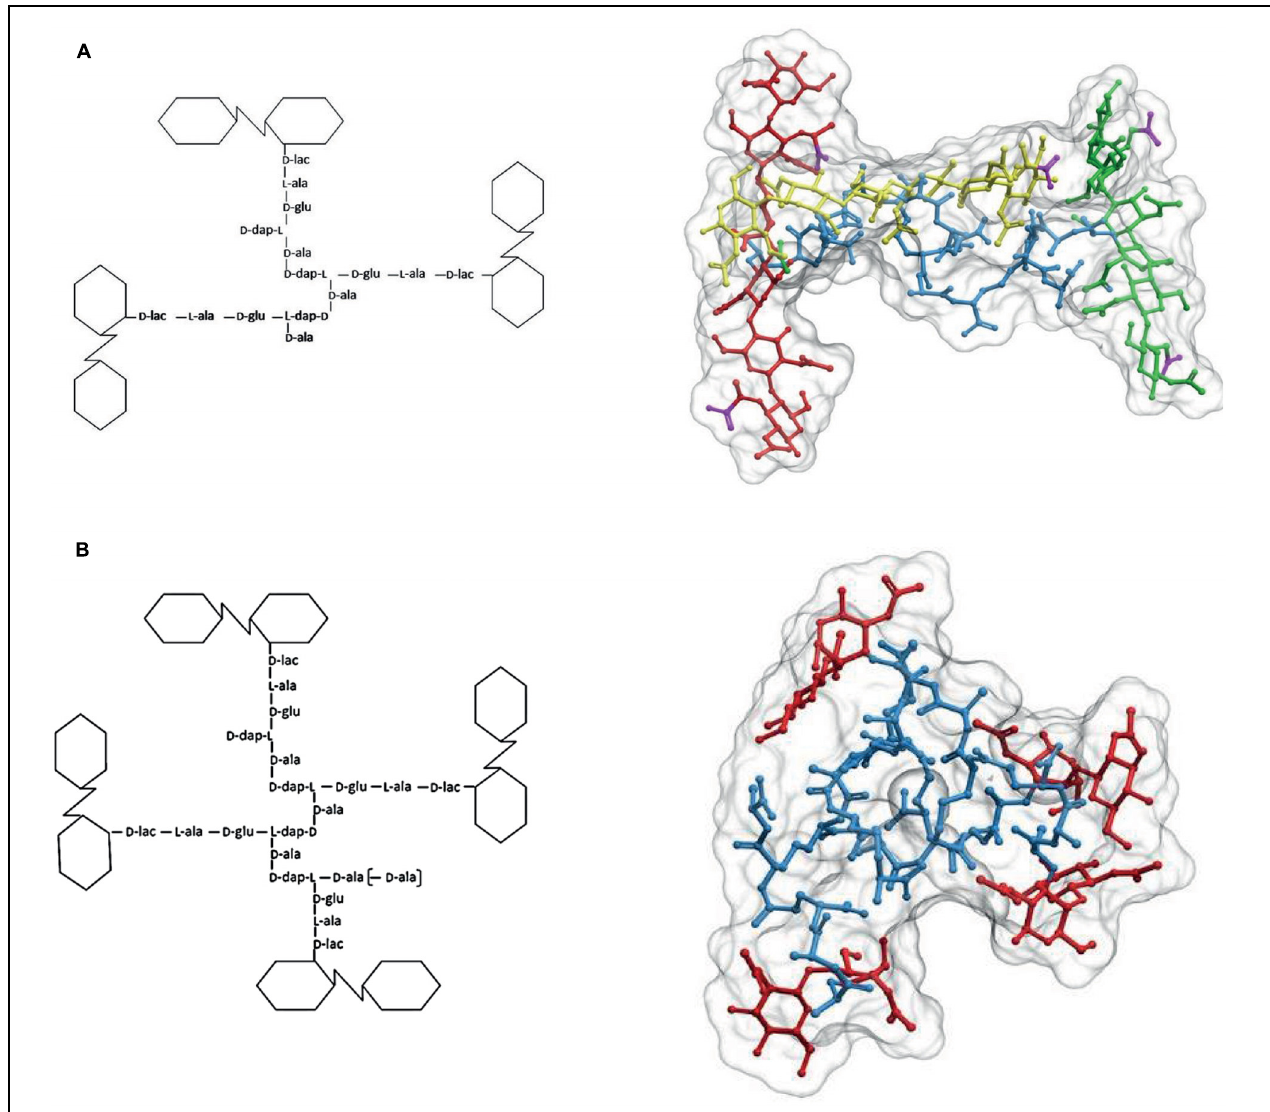
FIGURE 5 | The structure of cross-linked trimers and tetramers. (A) Simplified formula and 3D representation of a molecule of the DD cross-linked trimer tris -disaccharide tetrapeptide. For a better visualization of the relative orientation of the strands, the glycans were extended by the addition of two disaccharides, one at each side, to each of the cross-linked moieties.